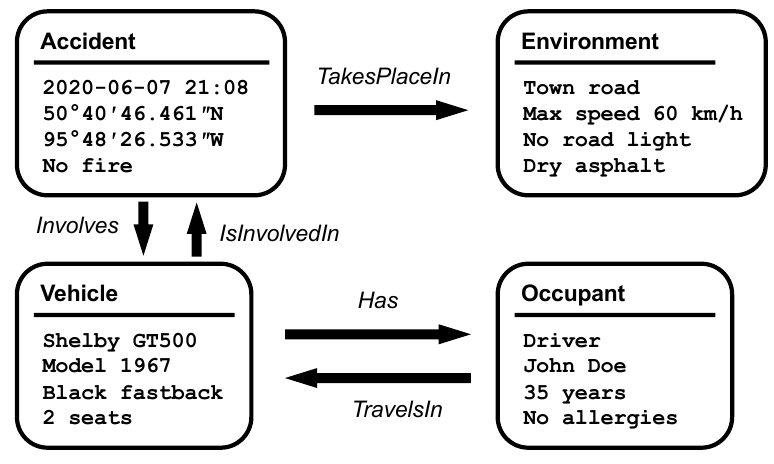
Figure 3. This example uses a subset of the Car Accident Ontology for VANETs (CAOVA) ontology to describe a car